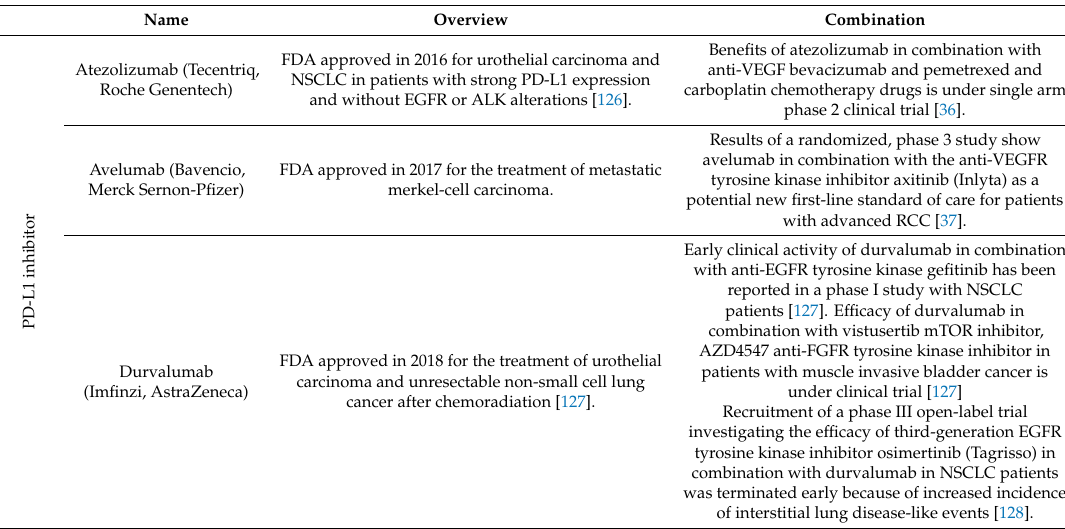
FDA approved in 2018 for the treatment of urothelial Durvalumab carcinoma and unresectable non-small cell lung (Imfinzi, AstraZeneca) cancer after chemoradiation [127].